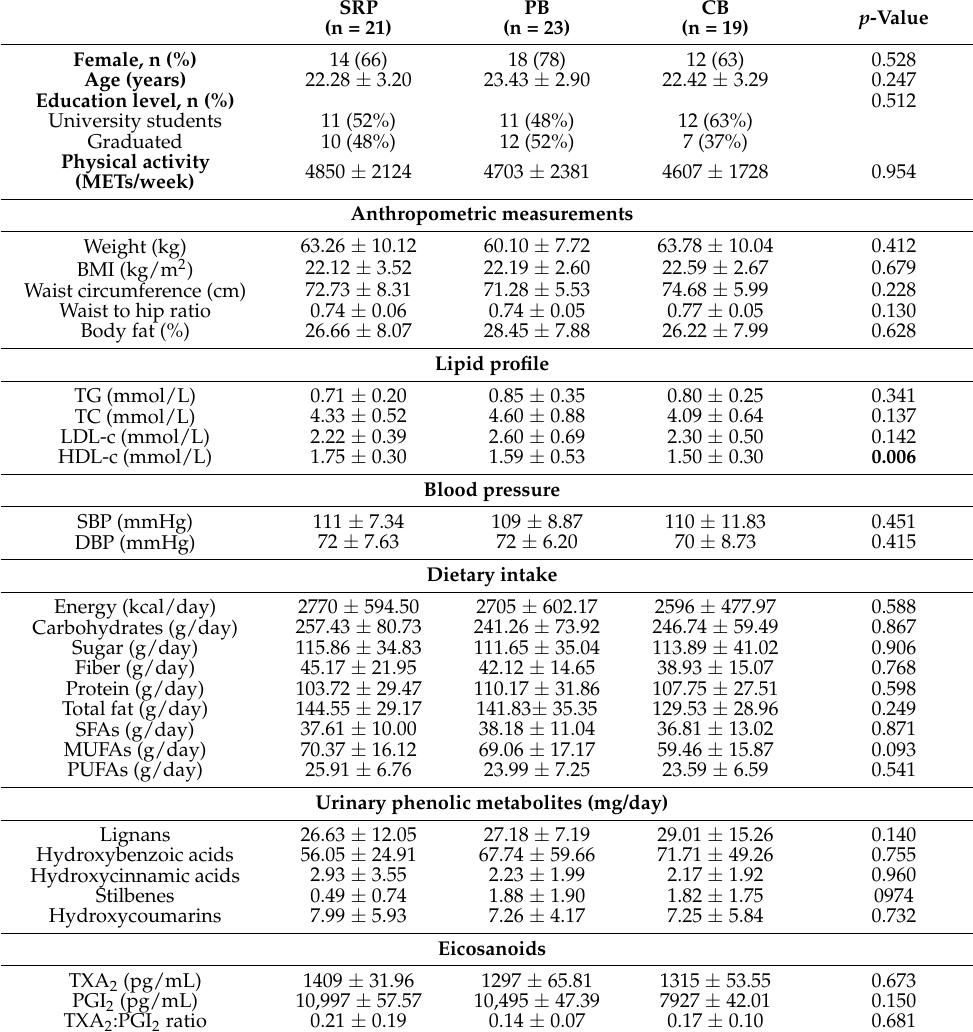
Table 1. General characteristics of the study population at